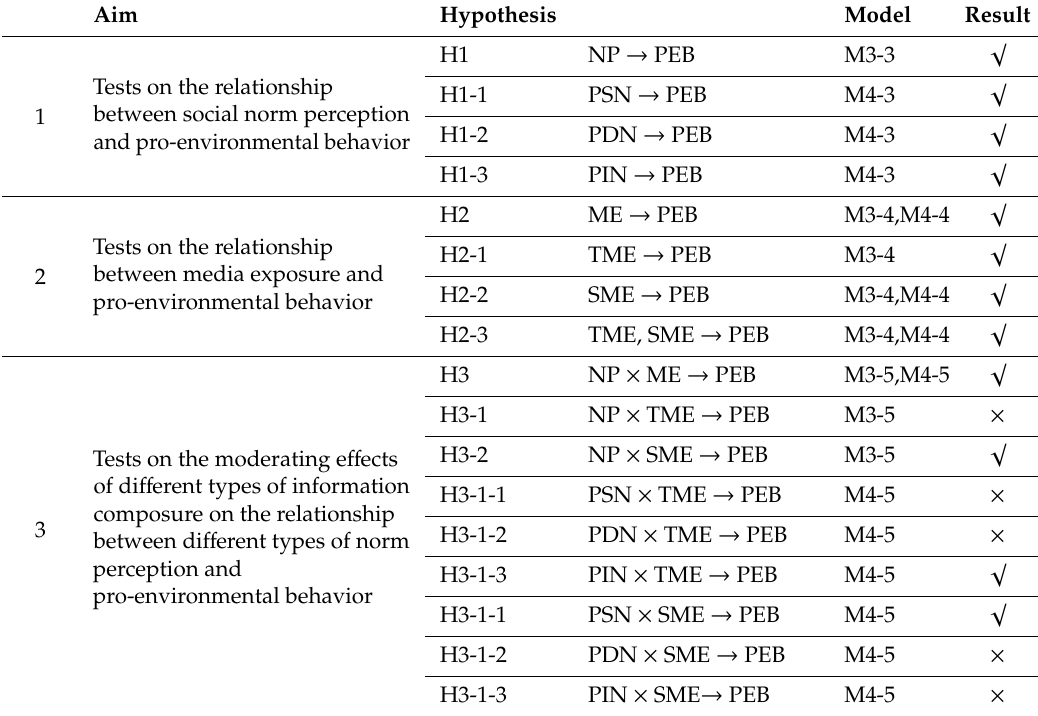
Table 5. A summary of test